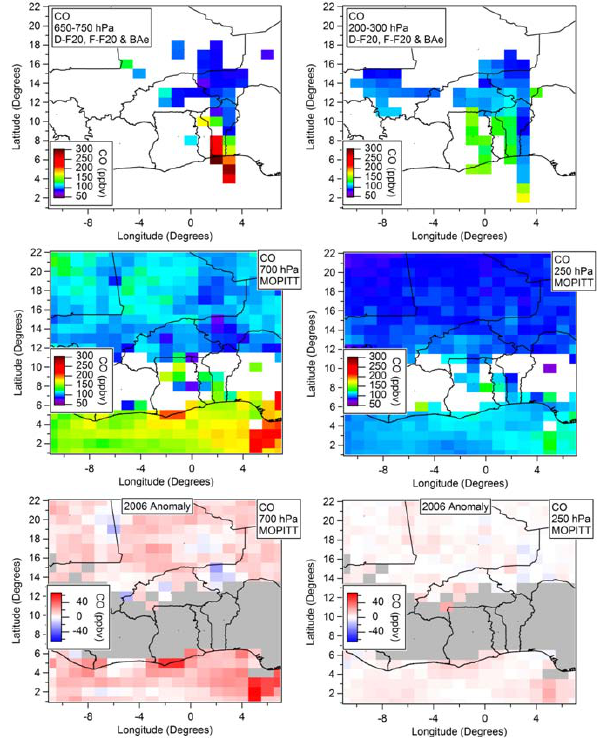
Fig. 6. Top panel: average CO concentrations based on 1-min data from the BAe-146, DLR Falcon and French Falcon between 20 July and 21 August for the layers 650–750hPa (left) and 200–300hPa (right). Note that the concentrations have been scaled according to the comparisons of standards. Middle panel: average CO con- centrations for August 2006 from MOPITT for the levels 700hPa (left) and 250hPa (right). Lower panel: MOPITT CO anomalies for August 2006 compared to the average for the years 2000–2008 (excluding 2001) for the levels 700hPa (left) and 250hPa